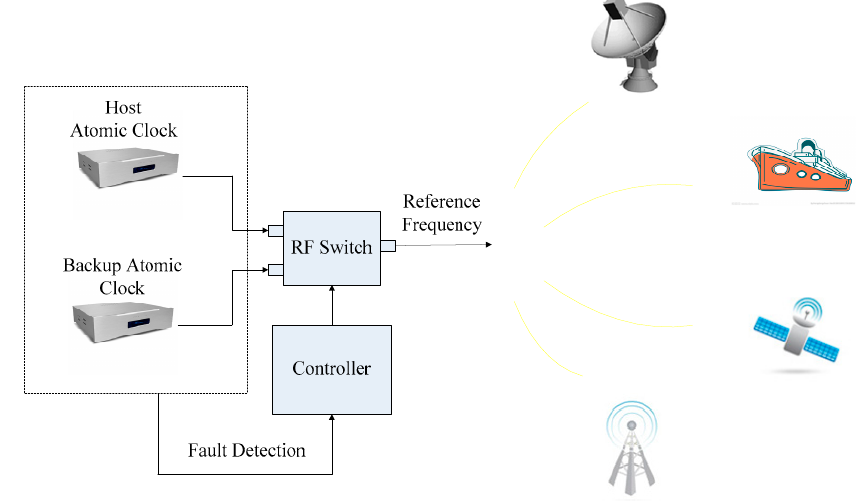
Figure 1. Applications of redundant atomic clock configurations.